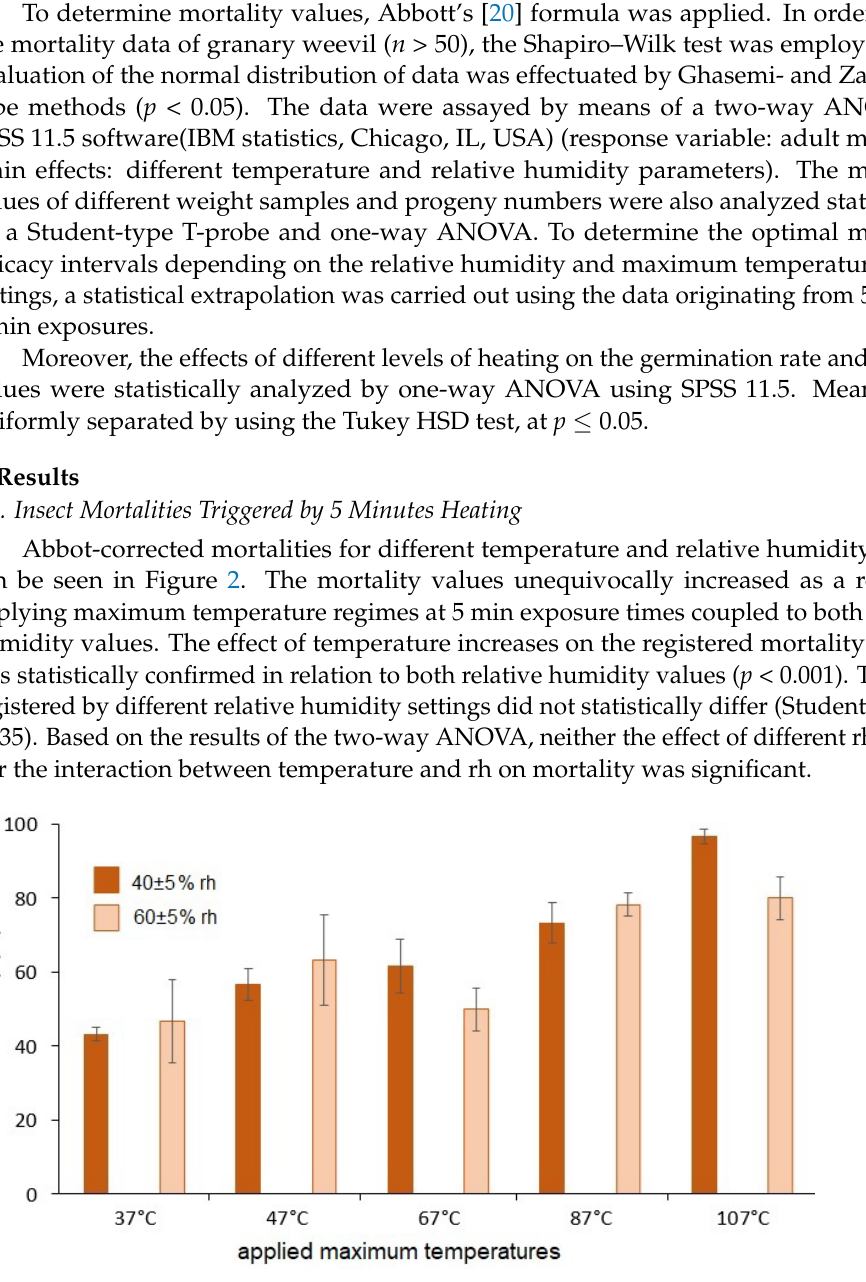
Figure 2. Abbott-corrected percentage mortality of S. granarius adults (mean ± SE) treated with two different relative humidity and maximum temperatures as a function of 5 min exposure times [20].